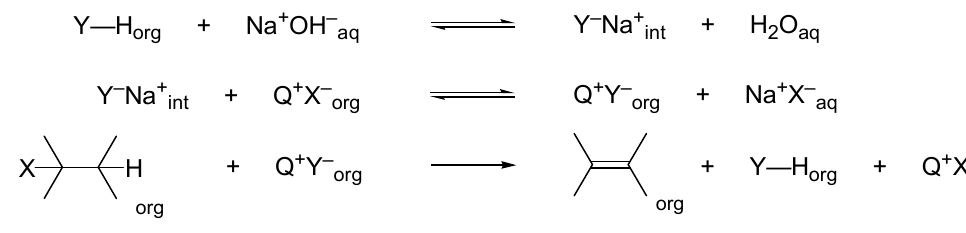
Scheme 18. Concept of cocatalysis in PTC β‐ elimination reactions.